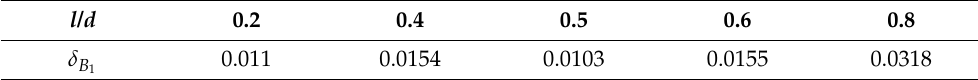
Table 2. Homogeneity of the RF excitation field corresponding to the length-to-diameter ratio.